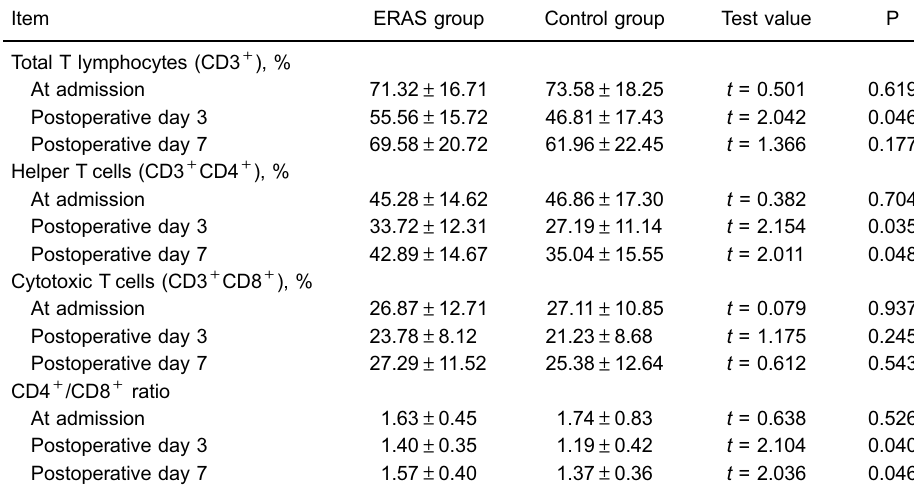
Table 8. Comparison of T lymphocyte subsets between the two